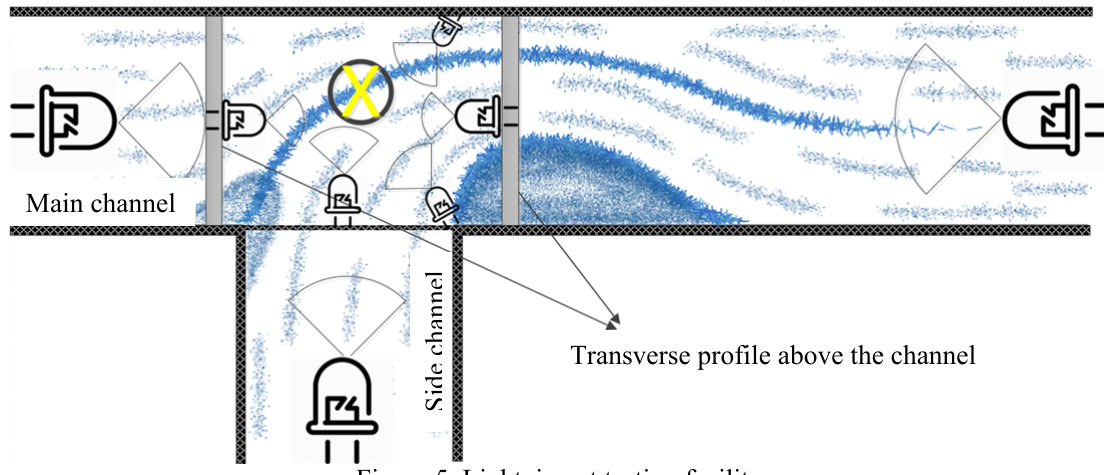
Figure 5. Lightning at testing